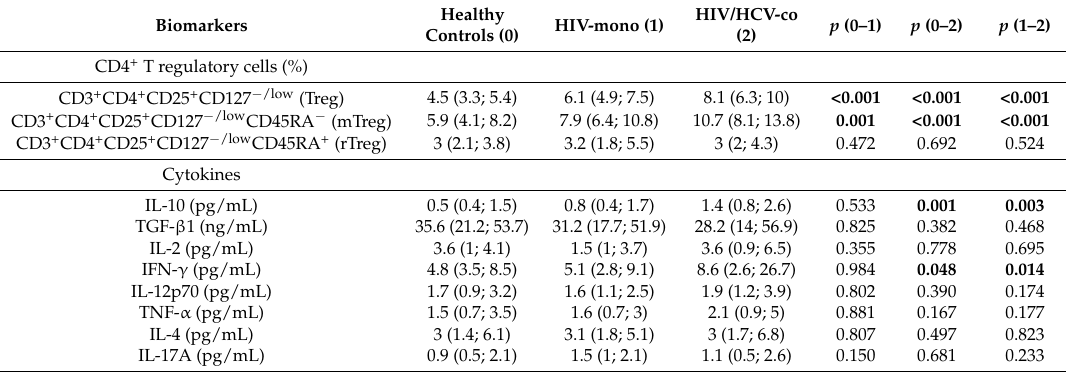
Table 2. Summary of markers of peripheral CD4 + Treg cells and plasma cytokines in healthy donors, HIV-monoinfected patients, and HIV/HCV-coinfected